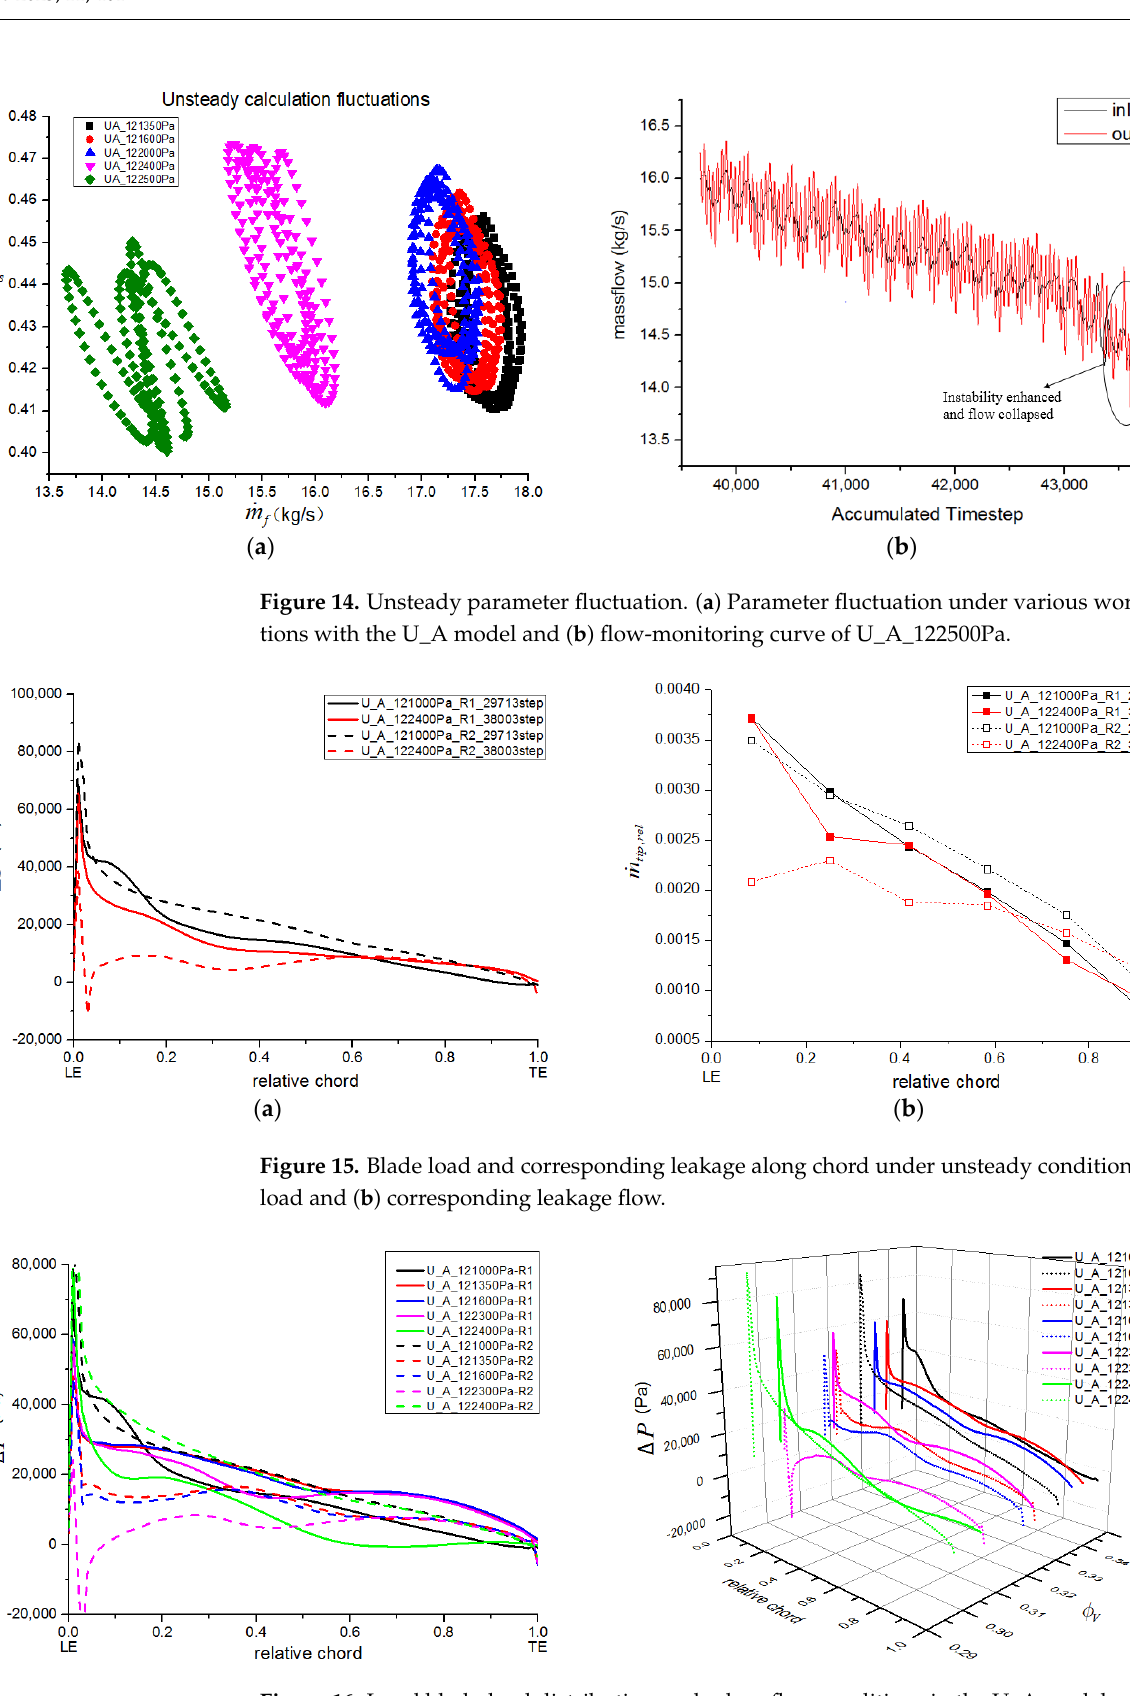
Figure 16. L ocal blade-load distribution under low-flow conditions in the U_A